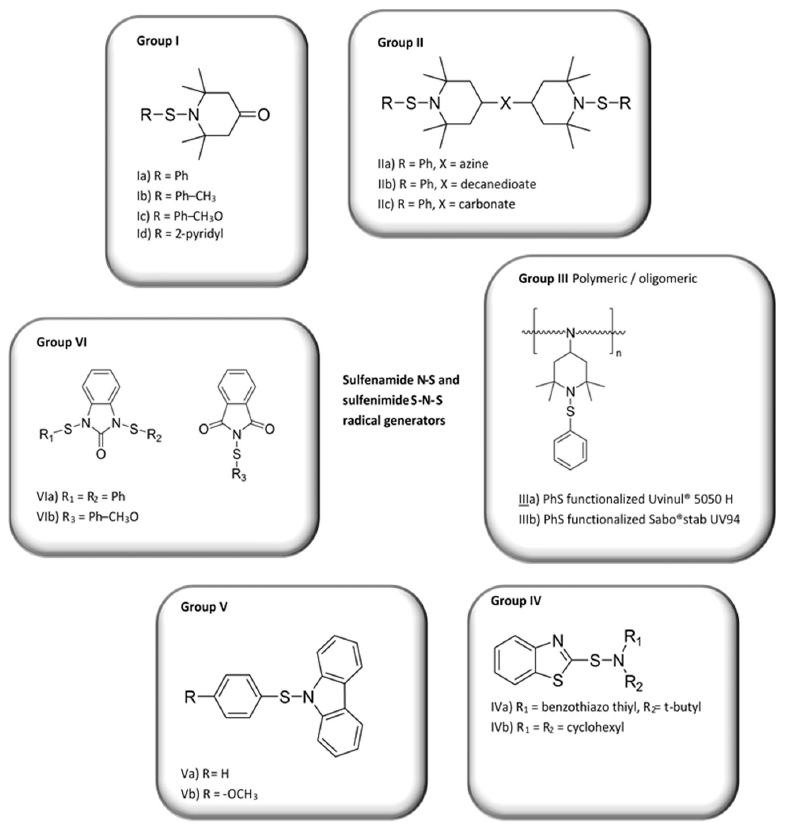
Figure 1. Grouping of sulfenamides.